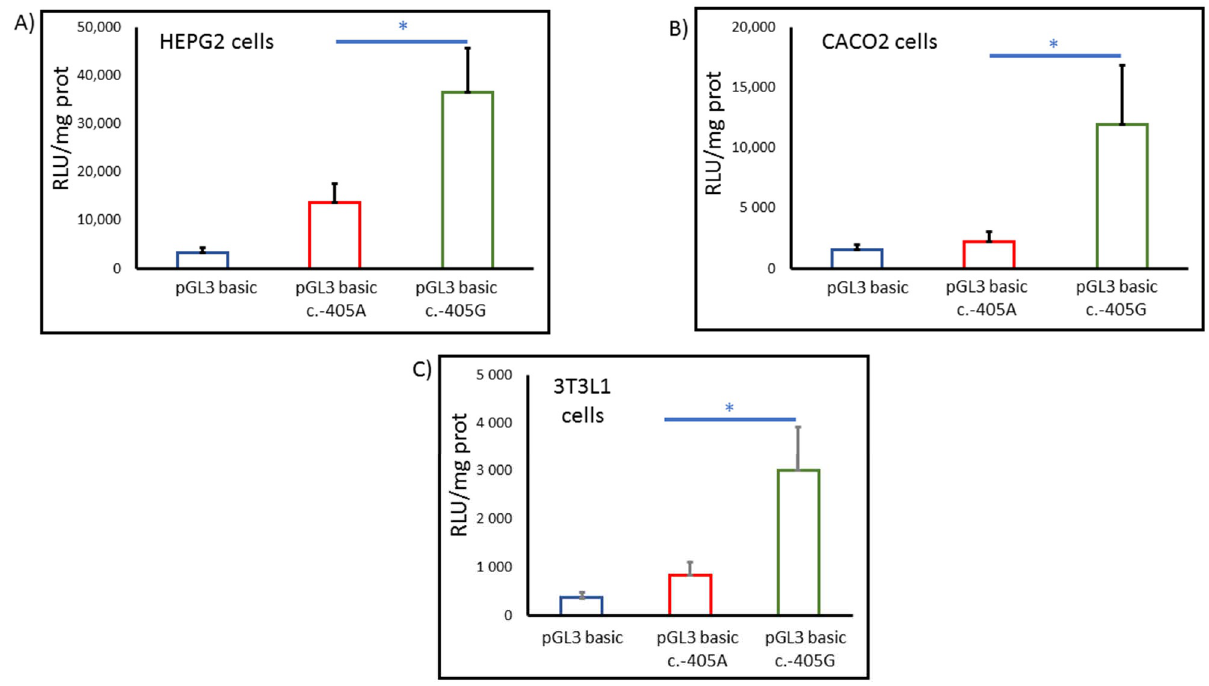
Figure 2. Transcription activity analysis of the -1094/-1 region of SREBF2 human promoter in several cell types (( A ): HepG2 cells, ( B ): Caco2 cells, ( C ): 3T3L1 cells). Cells were transiently transfected with SREBF2 luciferase reporter constructs plus promoterless Renilla plasmid. Data represent mean ± SD and are expressed as fold induction with respect to the empty vector (pGL3basic) (* significant).